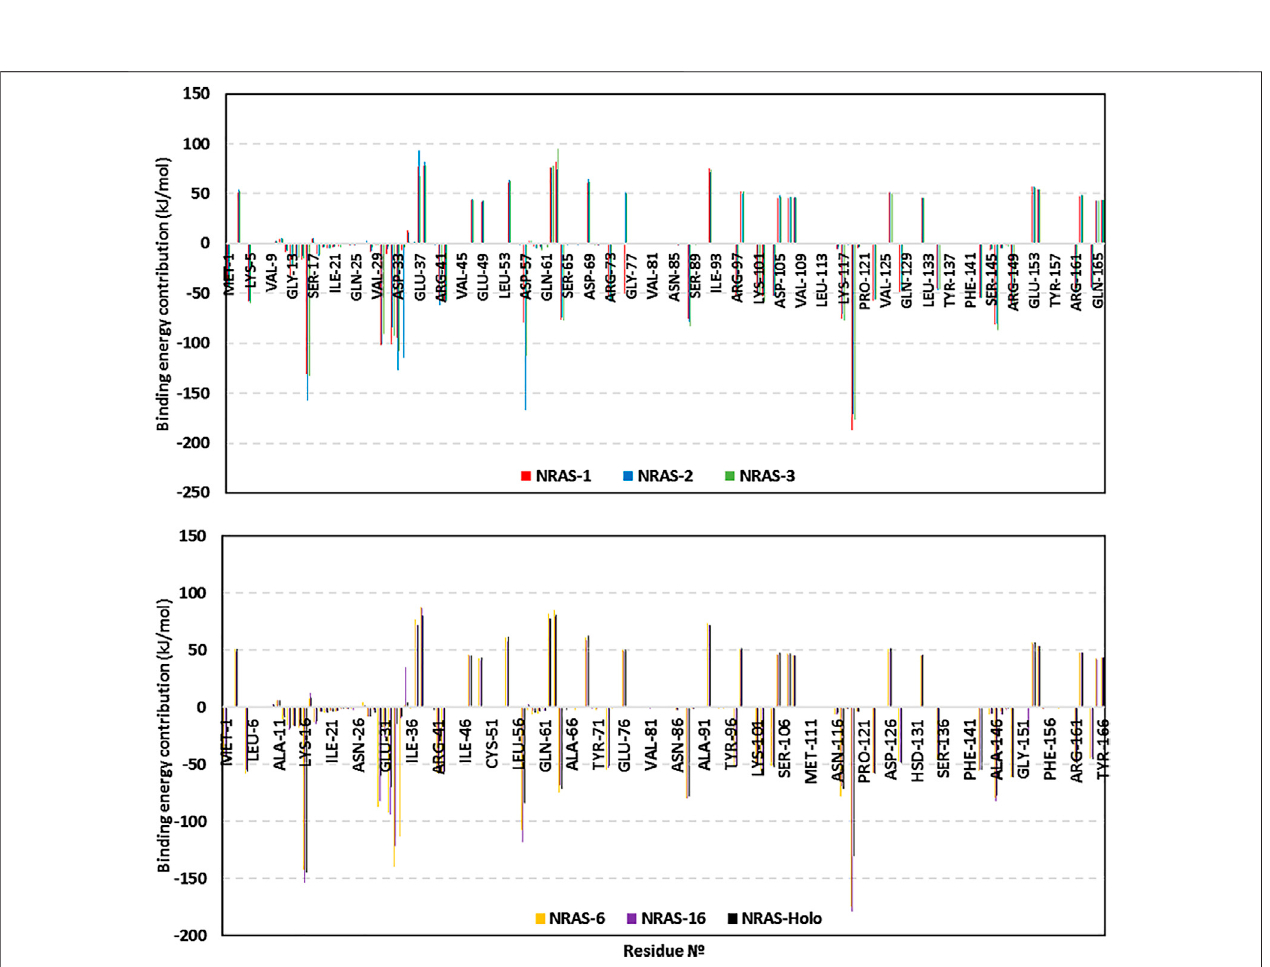
FIGURE 5 | Residue-oriented free binding energies for the simulated GTP-NRAS